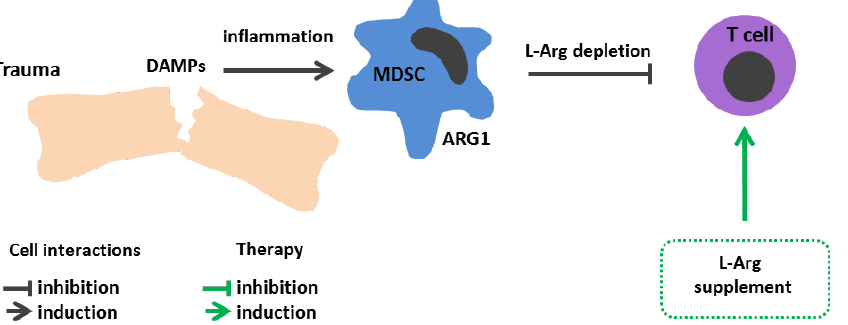
Figure 5. L-Arginine metabolism in trauma immunopathogenesis and arginine-dependent processes as a target of therapeutic approaches. MDSC differentiation is associated with excessive accumulation of DAMPs and other inflammatory mediators. The MDSC number, building up in injuries, accounts for decline in blood L-Arg and subsequent immunosuppression. Therapeutic strategies: L-Arg supplement increases lymphoproliferative response, wound healing and lowers the risk of infectious complications. ARG, arginase; DAMPs, danger associated molecular patterns; iNOS, inducible nitric oxide synthase; L-Arg, L-arginine; MDSCs, myeloid derived suppressor cells.